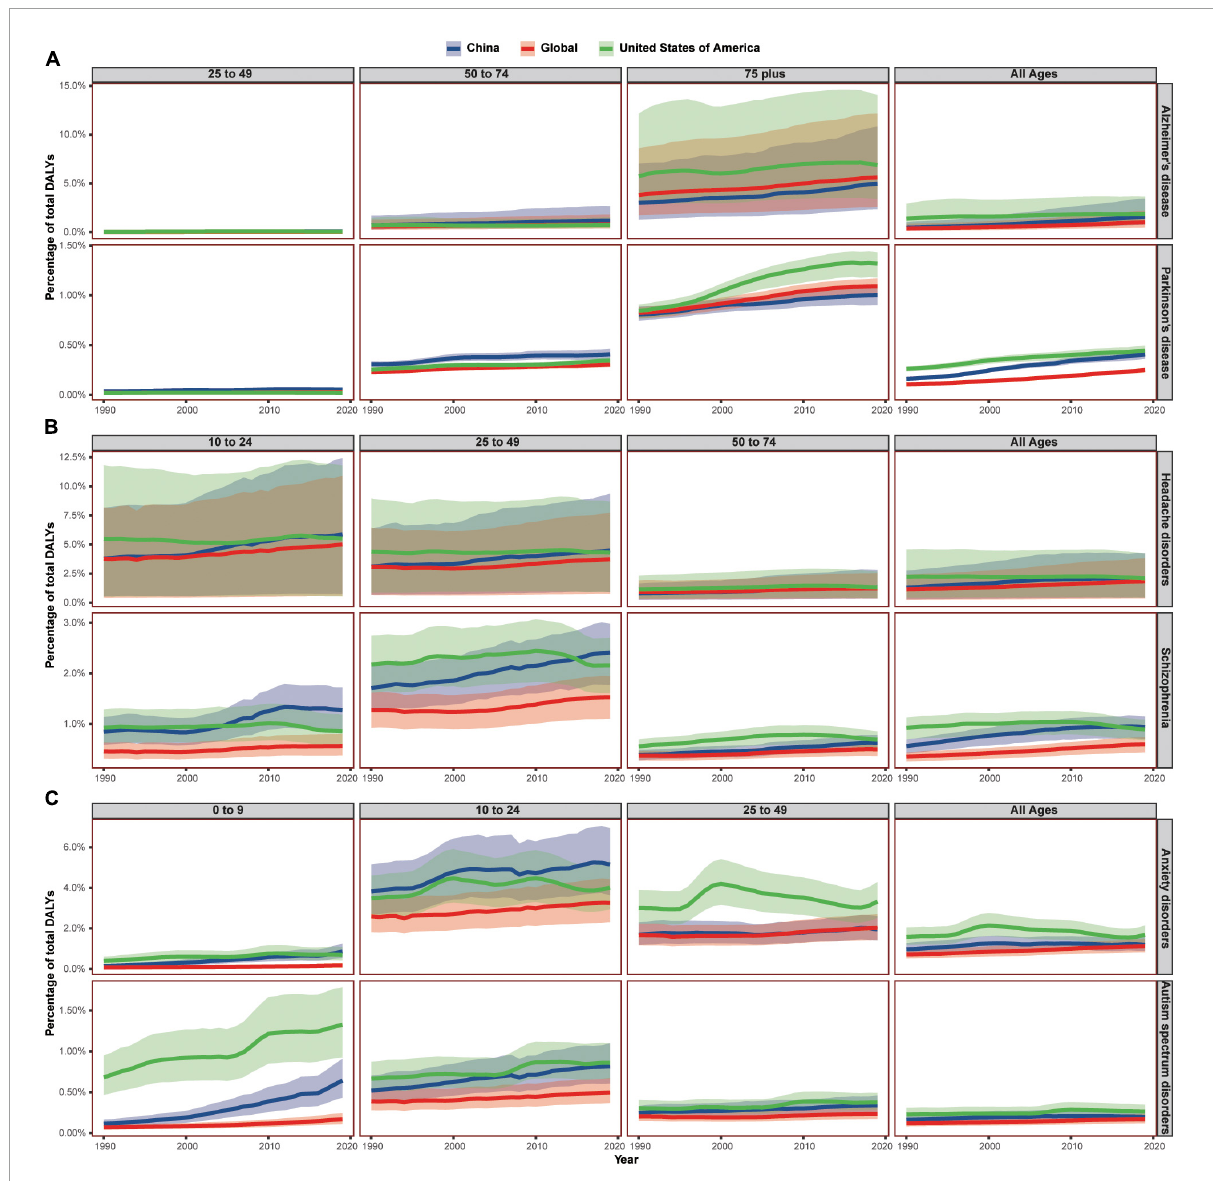
FIGURE3 The burden trend of six common neurological and mental disorders in China, the United States of America, and the world, by age group. (A) Showed the DALY percentage of Alzheimer’s disease and other dementias and Parkinson’s disease; (B) showed the DALY percentage of headache disorders and schizophrenia; (C) showed the DALY percentage of anxiety disorders and autism spectrum disorders. Shaded sections indicate 95% uncertainty intervals. DALYs, disability-adjusted